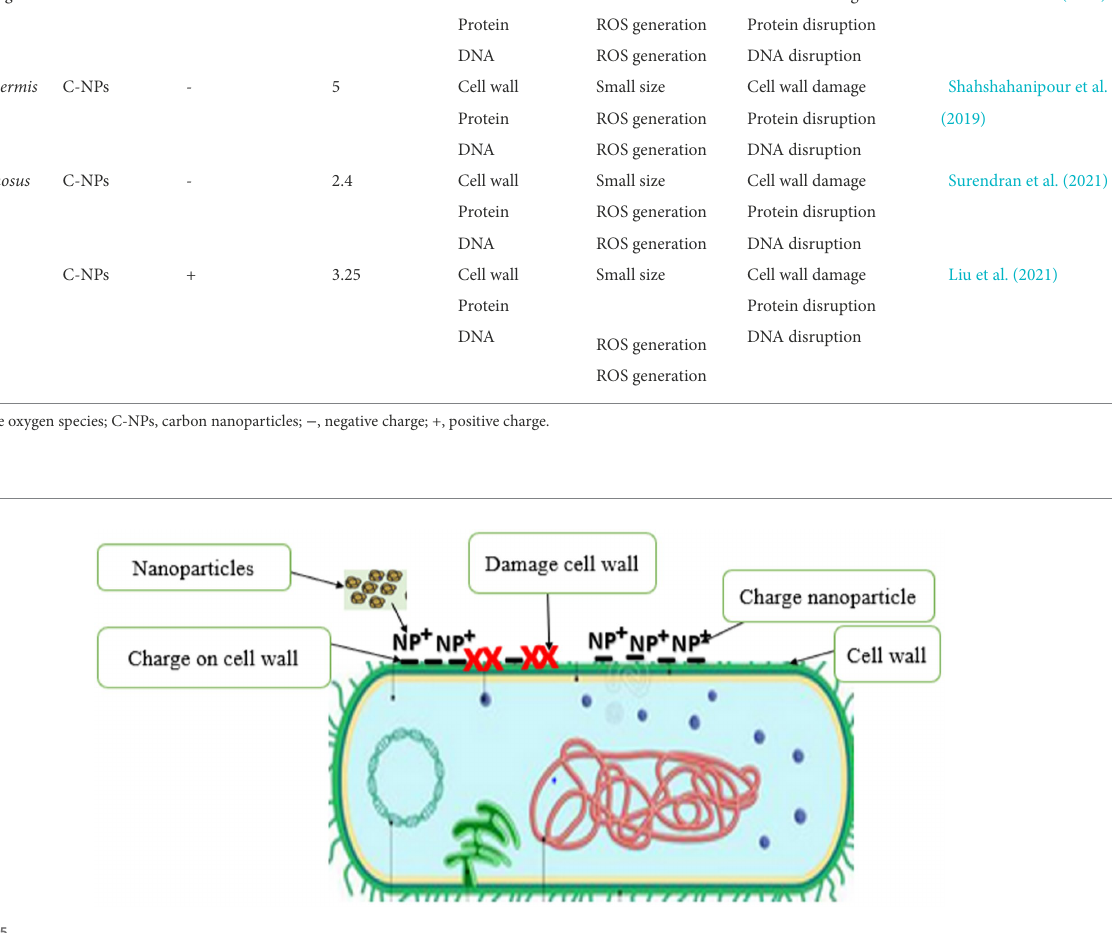
FIGURE 5 Disruption of bacteria cell wall by plant derived nanoparticles.